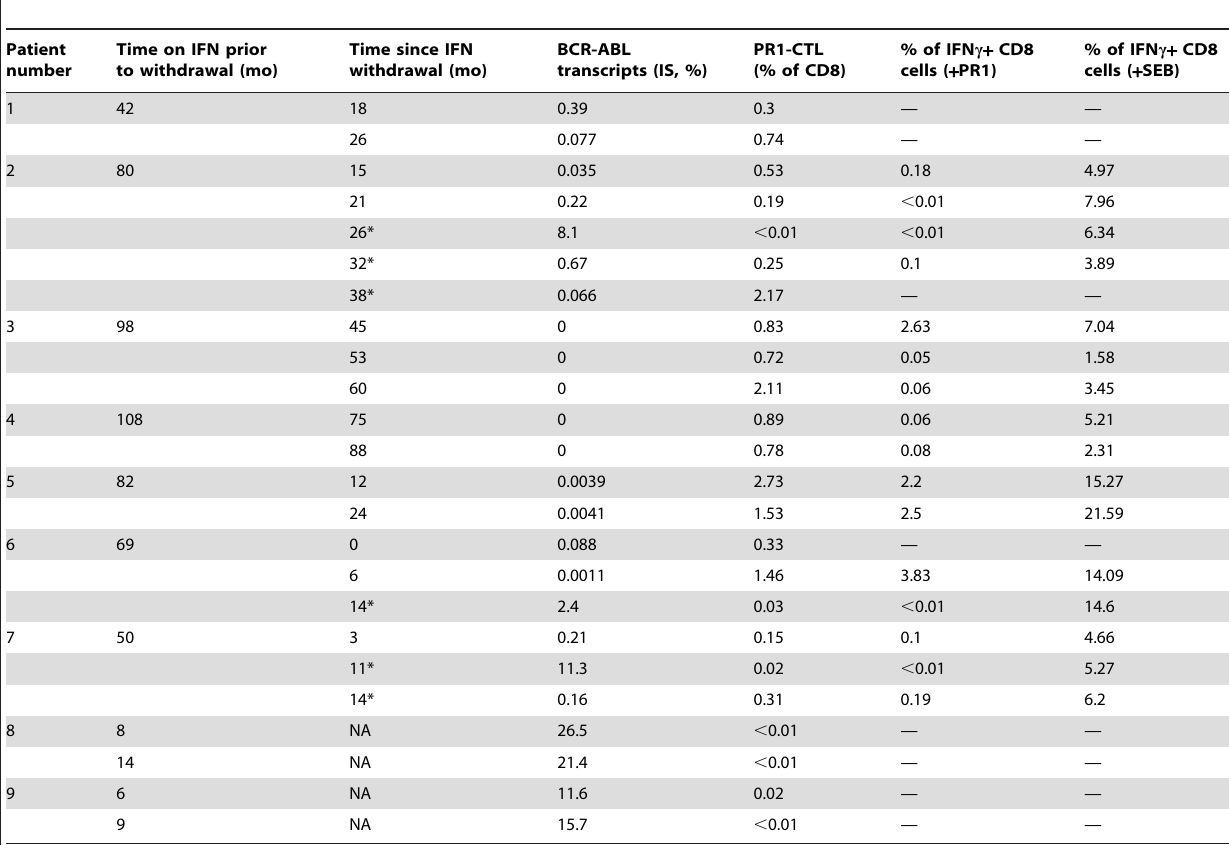
Table 2. Patient disease responses and PR1-CTL immune